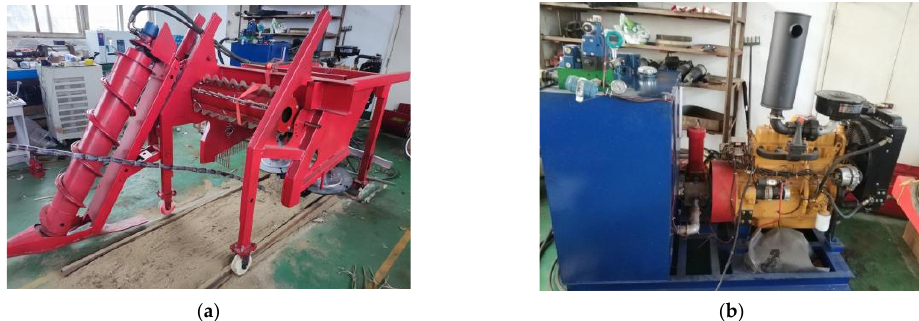
Figure 7. Test bench and the driving hydraulic station. ( a ) Test bench for the SLS; ( b ) hydraulic drive station.